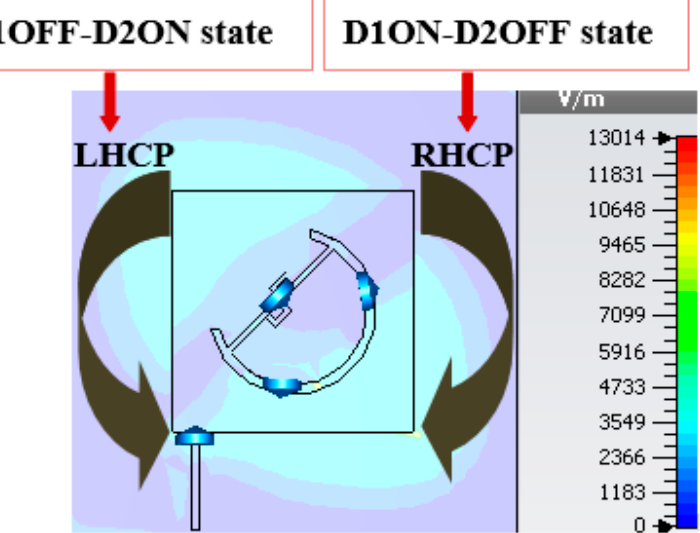
Figure 9. Captured view of the animated field showing the sense of rotation of circular polarization, for the proposed reconfigurable antenna.